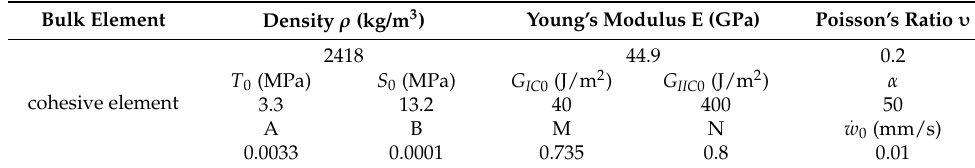
Figure 3. Effect of A, B, M and N on the model and simulation results: ( a ) DIF T and DIF G corresponding to different parameters; ( b ) stress–strain curves corresponding to various combinations of DIF T and DIF G . Table 1. Parameters for the model.